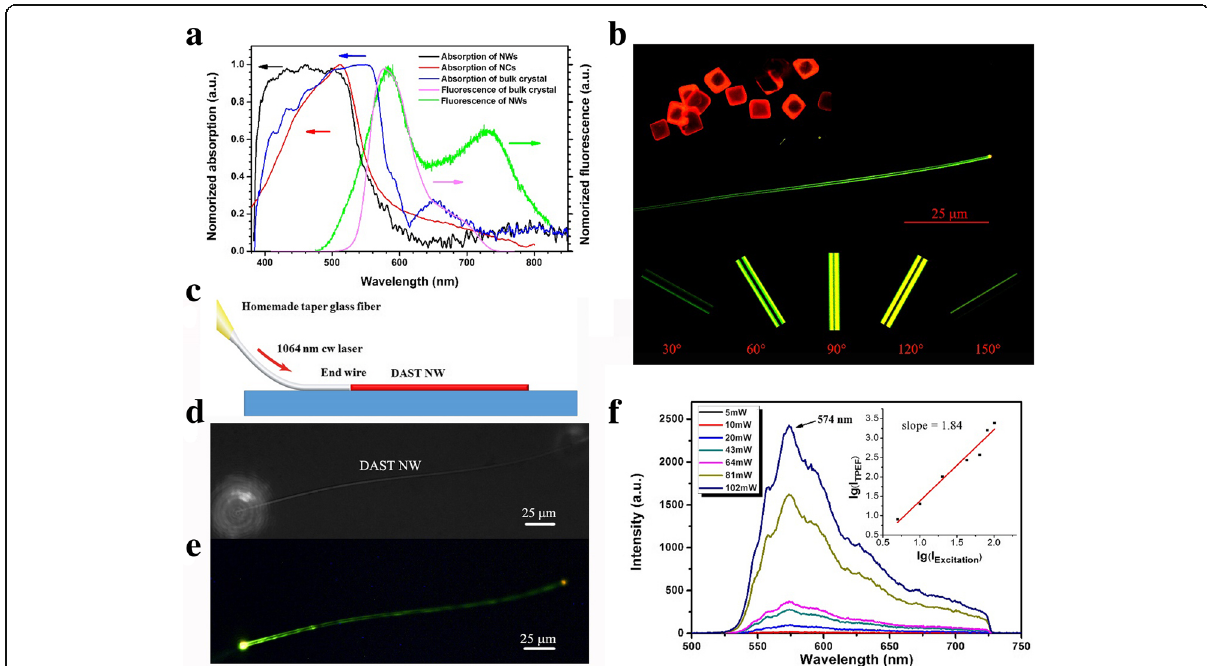
Fig. 3 a Absorption spectra of DAST NWs, NCs, and bulk crystals and fluorescence spectra of DAST NWs and bulk crystals excited by a 407 nm laser. b Fluorescence images of DAST MCs (top left), a DAST NW (center), and the DAST NW at different polarization angles (bottom). c Optical setup for TPEF measurements. d Top view of a DAST NW with 1064 nm laser input. e TPEF image of a DAST NW upon irradiation by the 1064 nm cw laser. f TPEF spectra of the DAST NW at different input laser intensities, where the inset shows the logarithm of the TPEF intensity as a function of the logarithm of the input laser